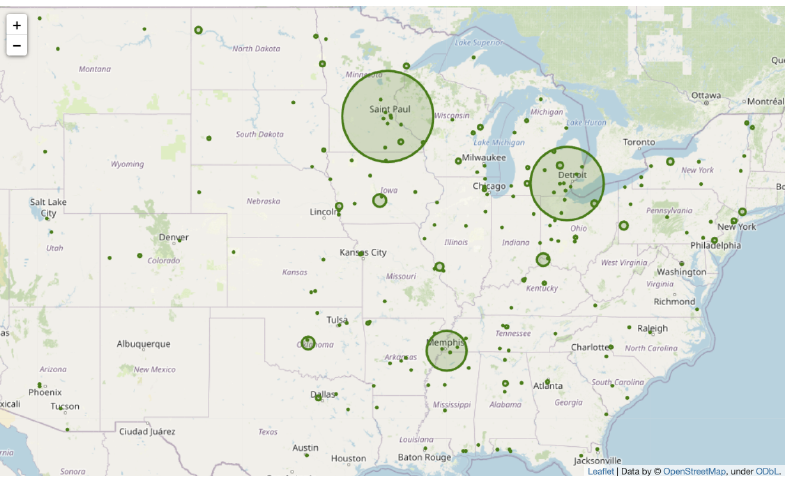
Figure 2. Distribution of the data across landing airports. The sizes of the circles are proportional to the amount of data for each